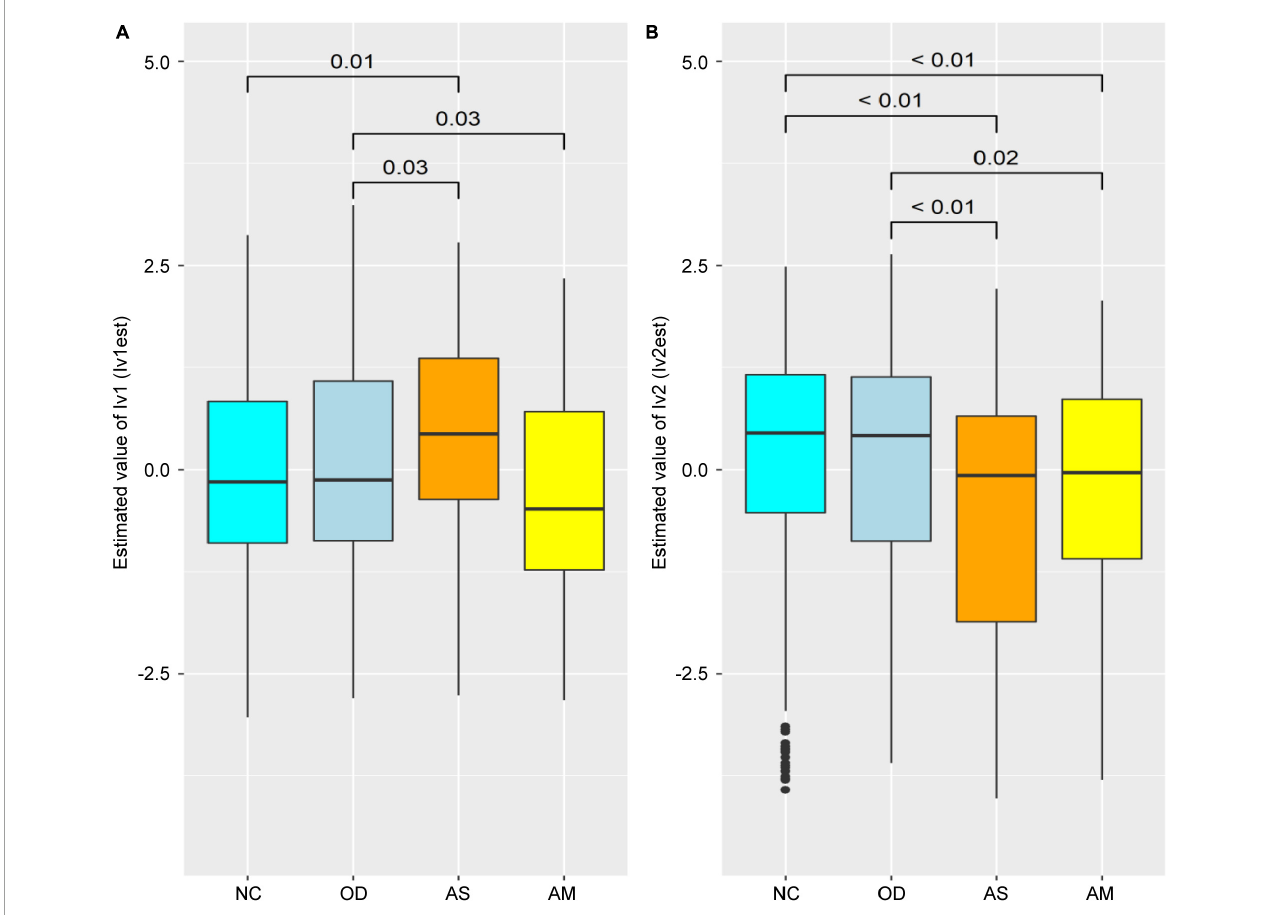
FIGURE5 Comparison of the latent variable values between groups for females estimated from the structural equation model in this figure. Estimated latent variable values for (A) lv1 and (B) lv2. Numerical values on the boxplots represent the p -values in the Wilcoxon–Mann–Whitney rank sum test. NC: normal controls ( n = 321), AS: patients with atopic dermatitis without other diseases ( n = 45), AM: patients with atopic dermatitis with other diseases ( n = 75), OD: patients with other diseases but without atopic dermatitis ( n = 1,669). The bottom line of the box represents the first quartile value, the middle line represents the median, the top line represents the third quartile, and the points represent outliers.